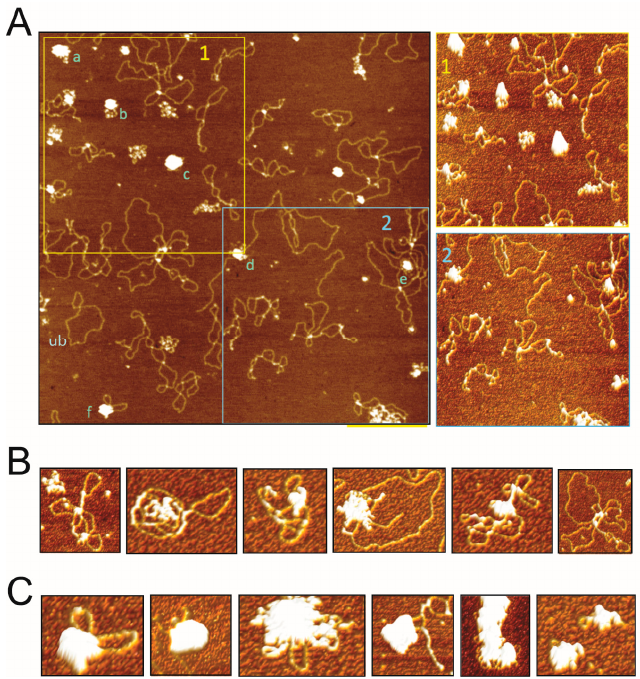
Figure 2. Atomic Force Microscopy (AFM) imaging of SIRV2_Gp1 ‐ DNA complexes. ( A ) A representative two ‐ dimensional topographic AFM height image displaying unbound, small and strongly condensed complexes. The large complexes were characterized by a height of 3 to 6 nm: the vertical dimension of complex (a) is 5.2 nm, (b) is 4.2 nm, (c) is 6.2 nm, (d) is 3.1 nm, (e) is 3.1 nm, and (f) is 5.4 nm (see also Figure S2). Three ‐ dimensional height images of area 1 (top right) and 2 (bottom right). A typical example of a presumably unbound DNA molecule is indicated with “ub”. ( B , C ) A selection of three ‐ dimensional AFM images zoomed into a single complex, subdivided into classes 1 ( B ) and 2 ( C ), as explained in the